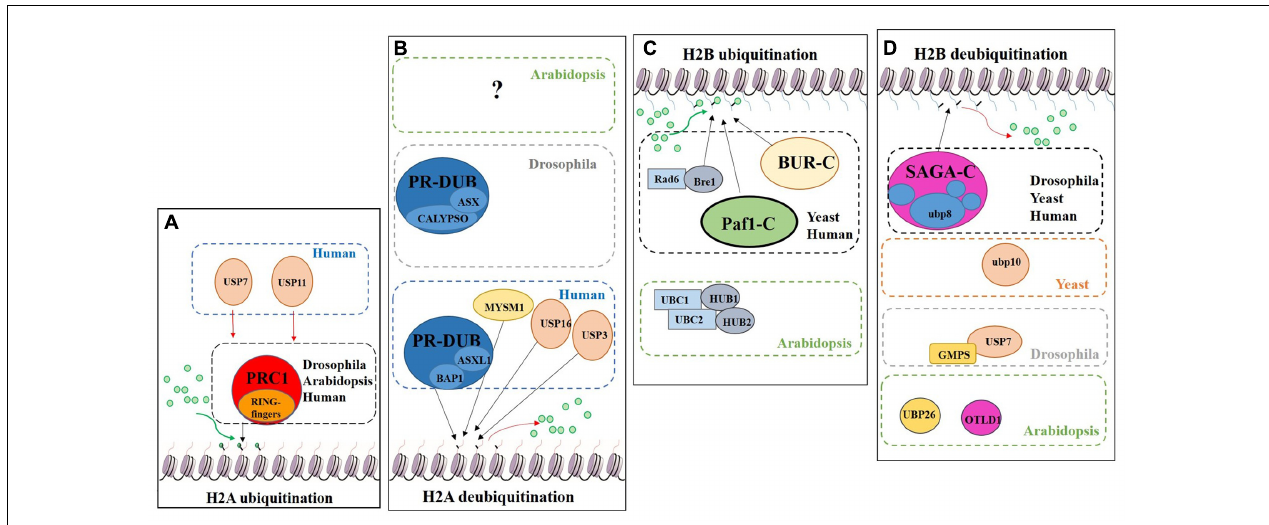
FIGURE 7 | Schematic model showing the regulation of DUBs and support complexes involved in H2A and H2B monoubiquitination/deubiquitination. The figure represents four processes, H2A monoubiquitination, H2A deubiquitination, H2B monoubiquitination and H2B deubiquitination. Ubiquitin is represented by green circles. (A) H2A monoubiquitination. PRC1 function is conserved in Eukaryotes. In humans two additional USPs have been described in this process. (B) H2A deubiquitination. The role of PR-DUB has been describe in humans and flies, as well as three additional DUBs. The proteins involved in this process in Arabidopsis are still unveiled. (C) H2B monoubiquitination. Bre1 and two complexes (BUR-C and Paf1-C) are involved in the deposition of ubiquitin on the H2B. In Arabidopsis only the orthologues of Bre1 and his partner Rad6, have been described in relation to H2Bub1. (D) H2B deubiquitination. Several DUBs are involved in this process in different organisms. Arabidopsis has a SAGA-like complex but its role in H2B deubiquitination has not been